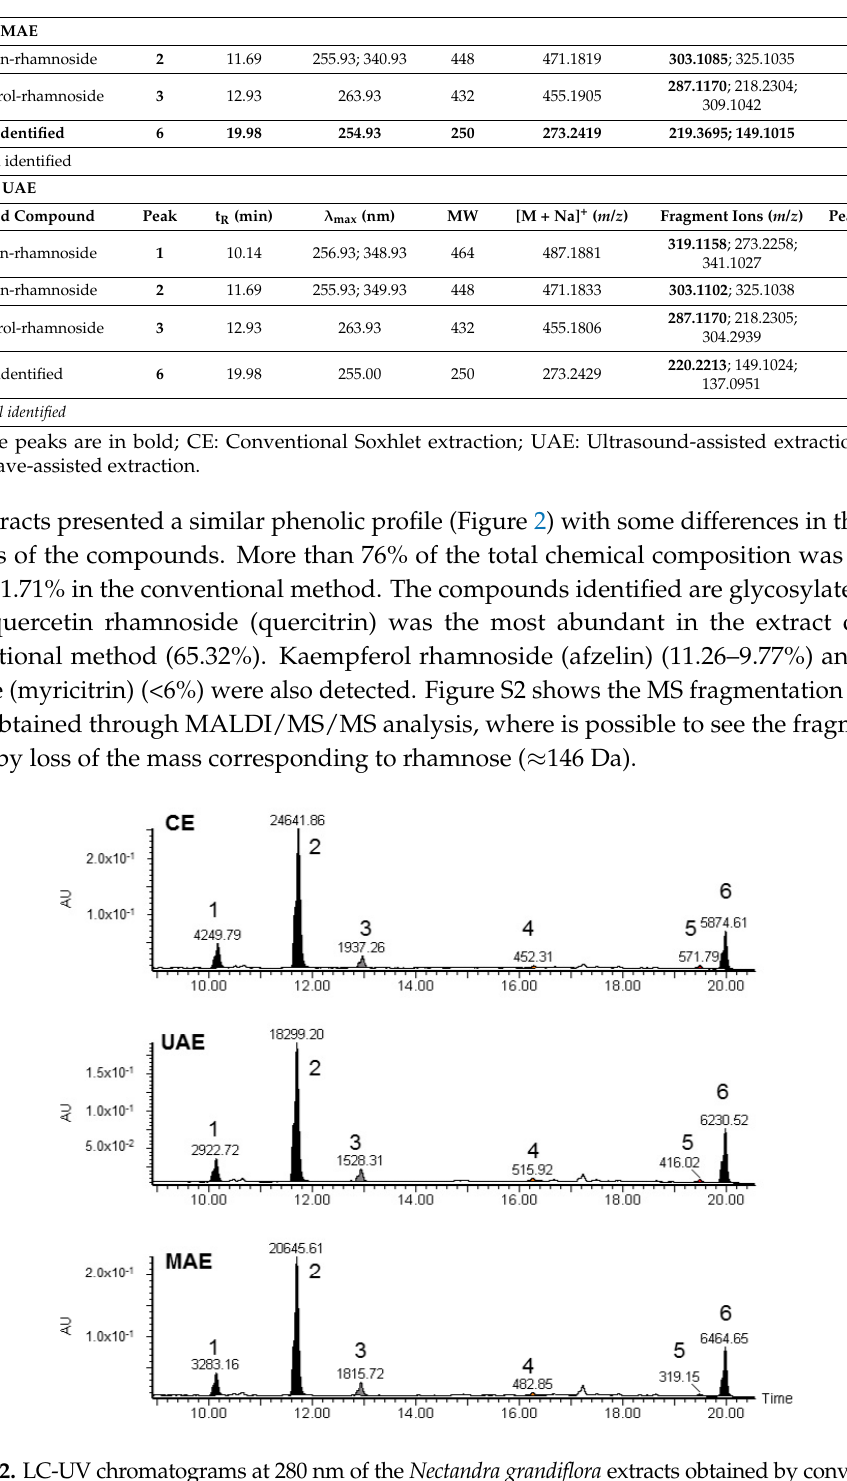
Figure 2. LC-UV chromatograms at 280 nm of the Nectandra grandiflora extracts obtained by conventional Soxhlet extraction (CE), ultrasound-assisted extraction (UAE) and microwave-assisted extraction (MAE). For peak identification, see Table